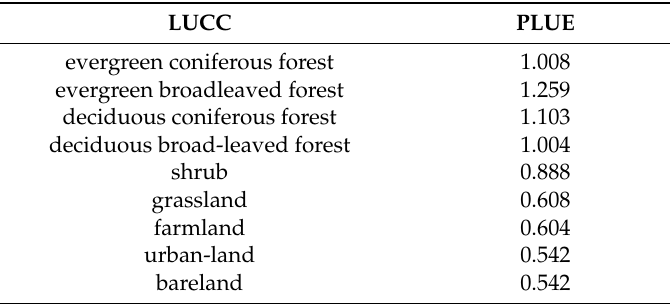
Table 3. The PLUE of different